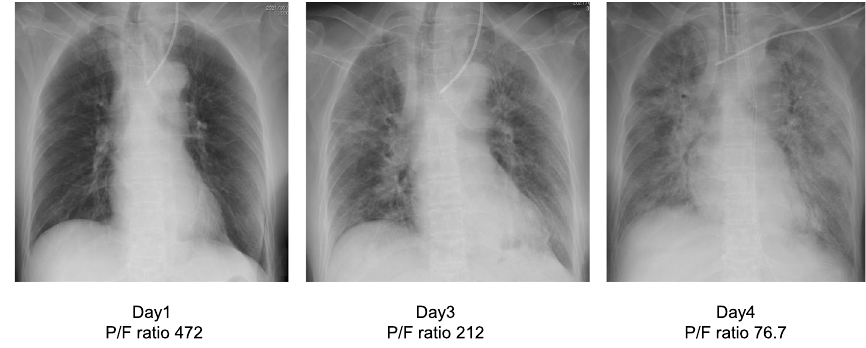
Fig. 2 Chest radiograph, P/F ratio